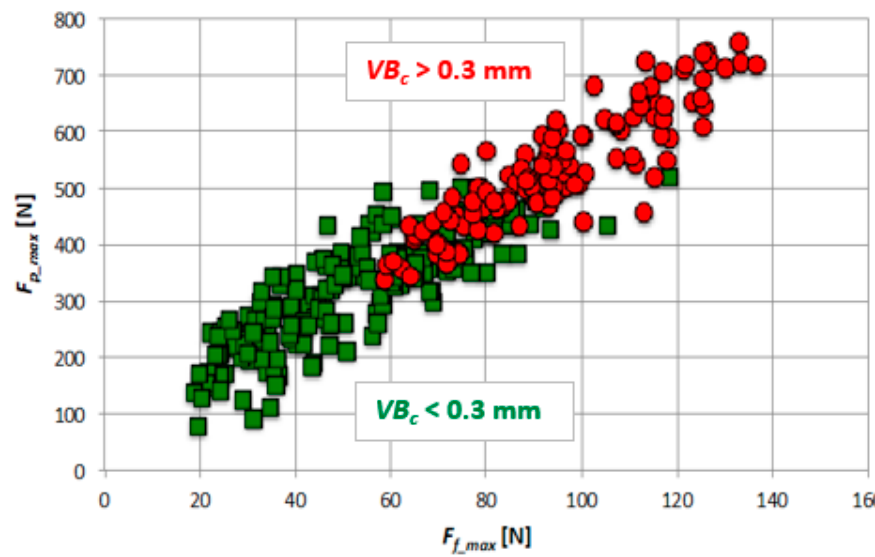
Figure 8. Two tool conditions for Fp_max and Ff_max measures (for 15 tool corners).